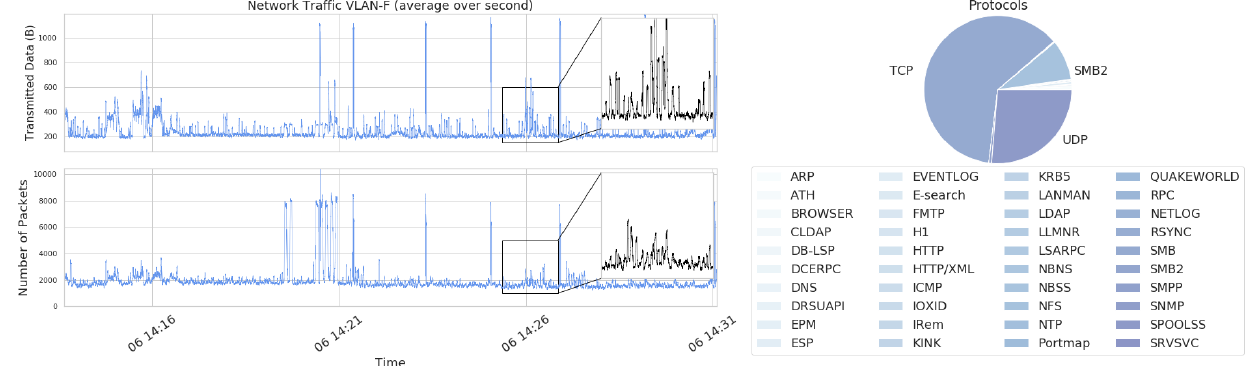
Figure 8. Traffic between the connectivity servers and operator and engineering stations in VLAN-F. The pie chart shows the proportion of consumed bandwidth by various communication